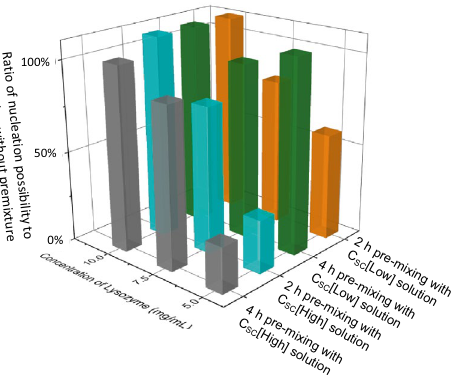
Figure 6. Ratios of nucleation possibility between the droplets with C Lys at 5–10 mg/mL and with premixed bio-templates at C SC [Low] or C SC [High] for 2 h and 4 h to the droplets with equal condition (no premixing).